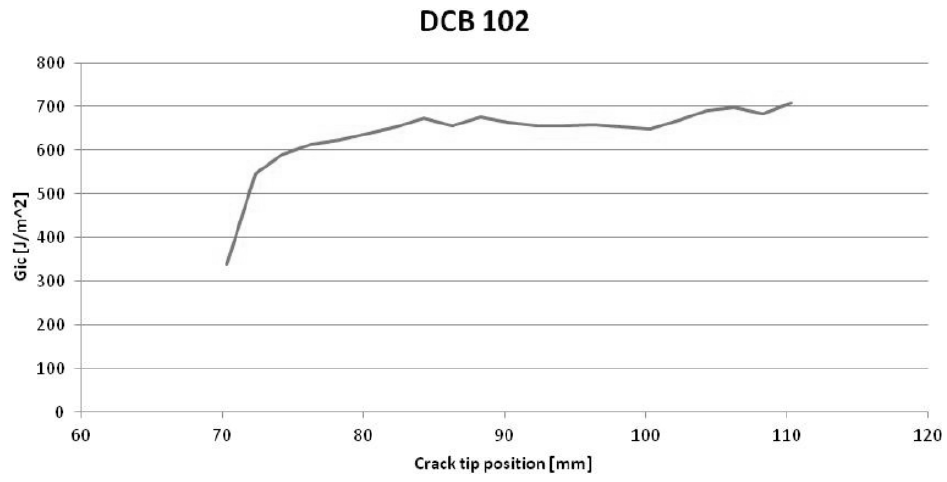
Figure 1. Example of a load-displacement curve from a DCB